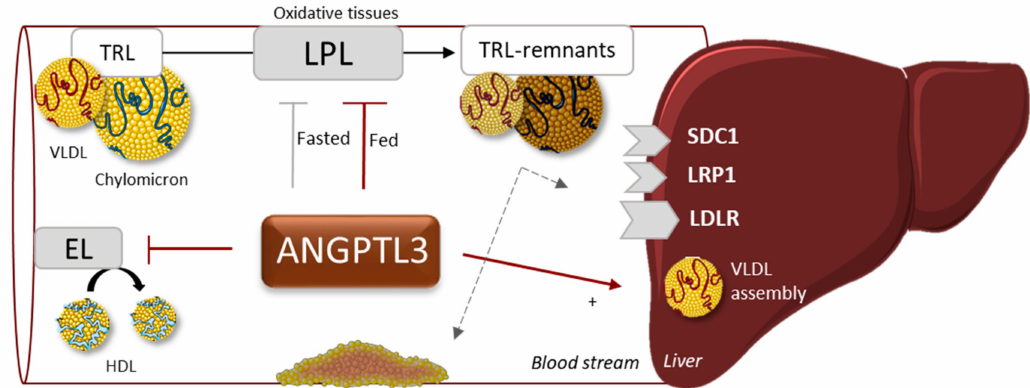
Figure 4. ANGPTL3 is reported to a ff ect plasma TG through inhibition of lipoprotein lipase (LPL), especiallyinthefedstateandHDLmetabolismthroughinhibitingEL-mediatedphospholipidhydrolysis. Last but not least, it also a ff ects the assembly of VLDL in the liver. Abbreviations: EL, endothelial lipase; HDL, high-density lipoprotein; VLDL, very-low-density lipoprotein; TRL, triglyceride-rich lipoproteins; SDC1, syndecan-1; LRP1, low-density lipoprotein receptor-related protein 1; LDLR, low-density lipoprotein